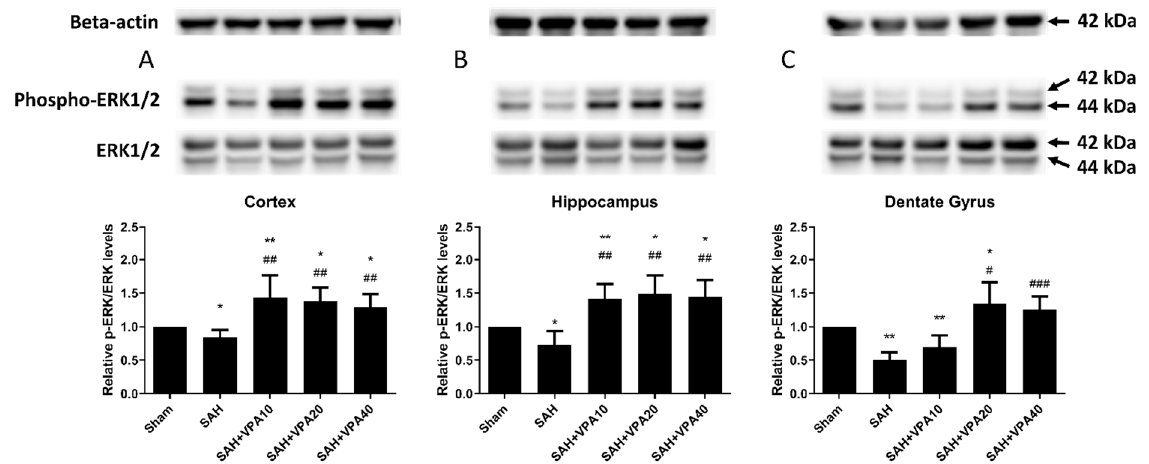
Figure 3. VPA enhanced ERK1/2 in brain tissue. ( A – C ) Top panel: representative expression of ERK 1/2 and phospho-ERK 1/2 proteins. Beta-actin was used as control. Lower panel: Quantification of relative p -ERK activity. All gels were run in the same experimental conditions ( n = 6). * p < 0.05, ** p < 0.01, compared with the sham group, # p < 0.05, ## p < 0.01, ### p < 0.001, compared with the SAH group.